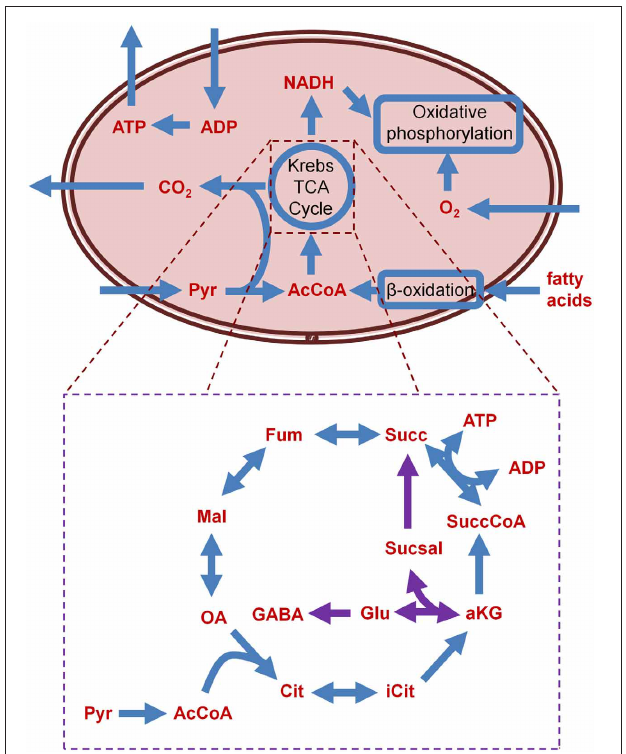
FIGURE 2 | Schematic of the major metabolic processes housed in the mitochondria, and detail of the TCA cycle and the GABA shunt (GABA shunt related reactions in purple). AcCoA, acetyl coenzyme A; ADP, adenosine diphosphate; aKG, α -ketoglutarate; ATP, adenosine triphosphate; Cit, citrate; Fum, fumarate; GABA, γ -aminobutyric acid; Glu, glutamate; iCit, isocitrate; Mal, malate; NADH, nicotamide adenine dinucleotide; OA, oxaloacetate; Pyr, pyruvate; Succ, succinate; SuccCoA, succinyl-coenzyme A; Sucsal, succinate